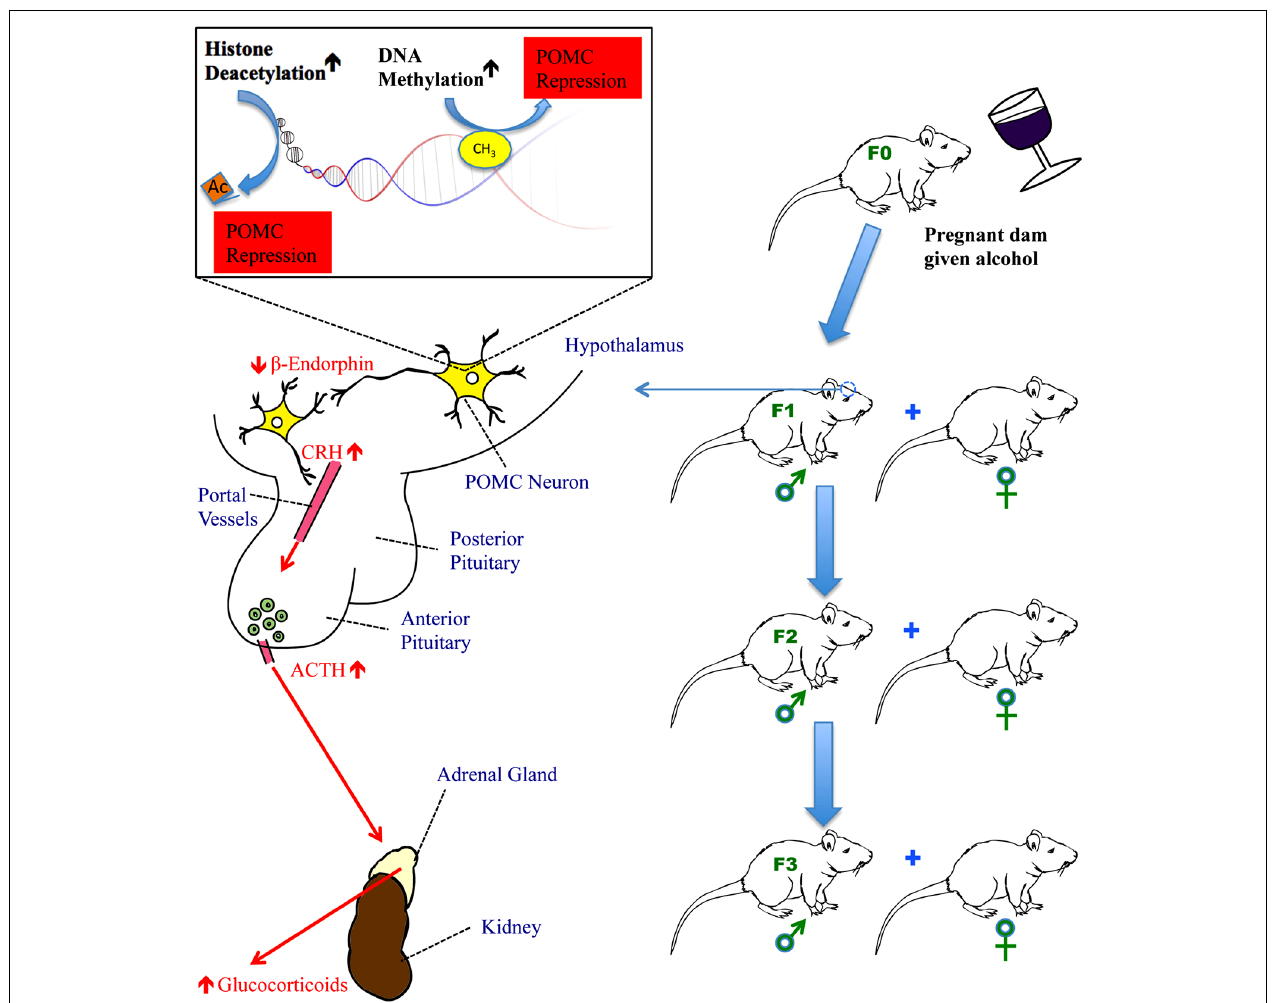
FIGURE 1 |The impact of fetal alcohol exposure on the hypothalamic-pituitary-adrenal (HPA) axis. Fetal alcohol exposure increases DNA methyltransferase activity to methylate CpGs in the promoter of the POMC gene in the hypothalamus and activates histone deacetylases to remove acetyl groups from histones in the proximity of the POMC gene. Both methylation and deacetylation lead to the repression of POMC gene transcription. This results in reduced production of β -endorphin, a peptide derived from POMC gene, in the hypothalamus. Reduced β -endorphin production disrupts the normal